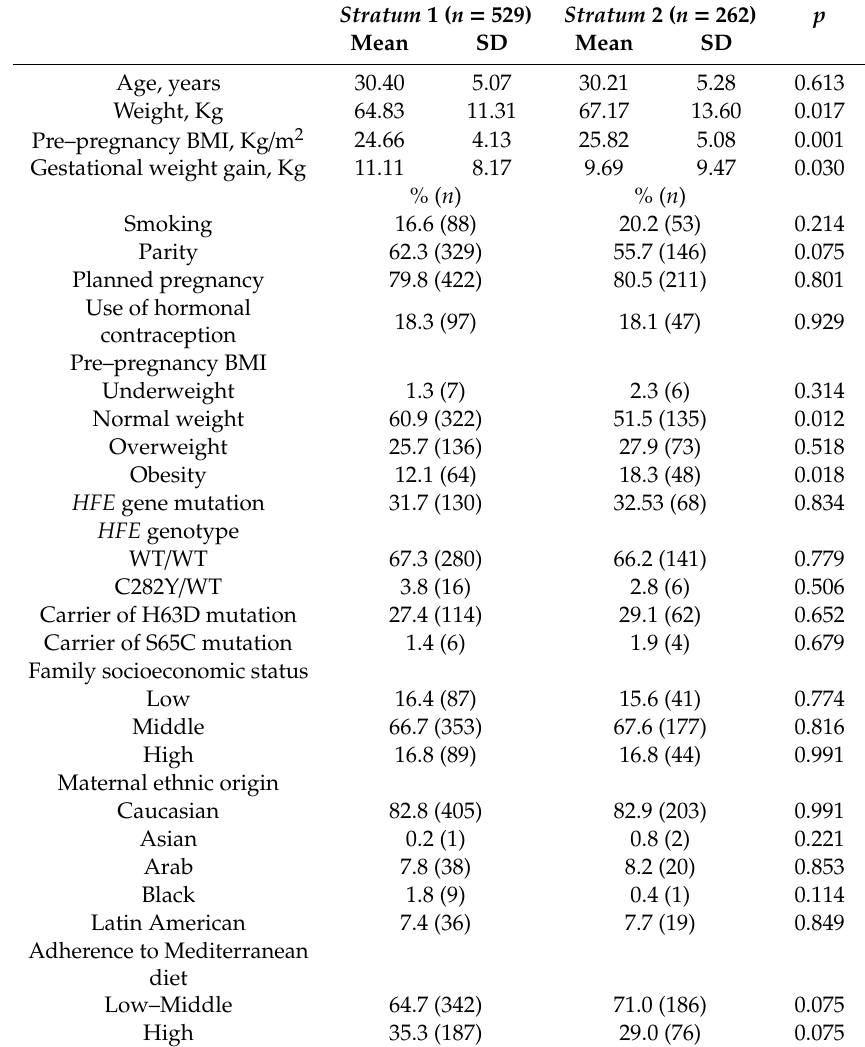
Table 1. Baseline characteristics of the study